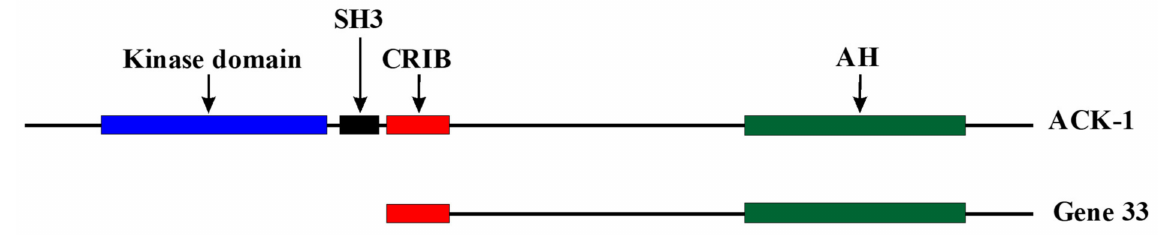
Figure 1. Comparison of linear structures of Gene 33 and ACK-1. SH3: Src homology 3 domain, CRIB: Cdc42/Rac interactive and binding domain. AH: Ack homology